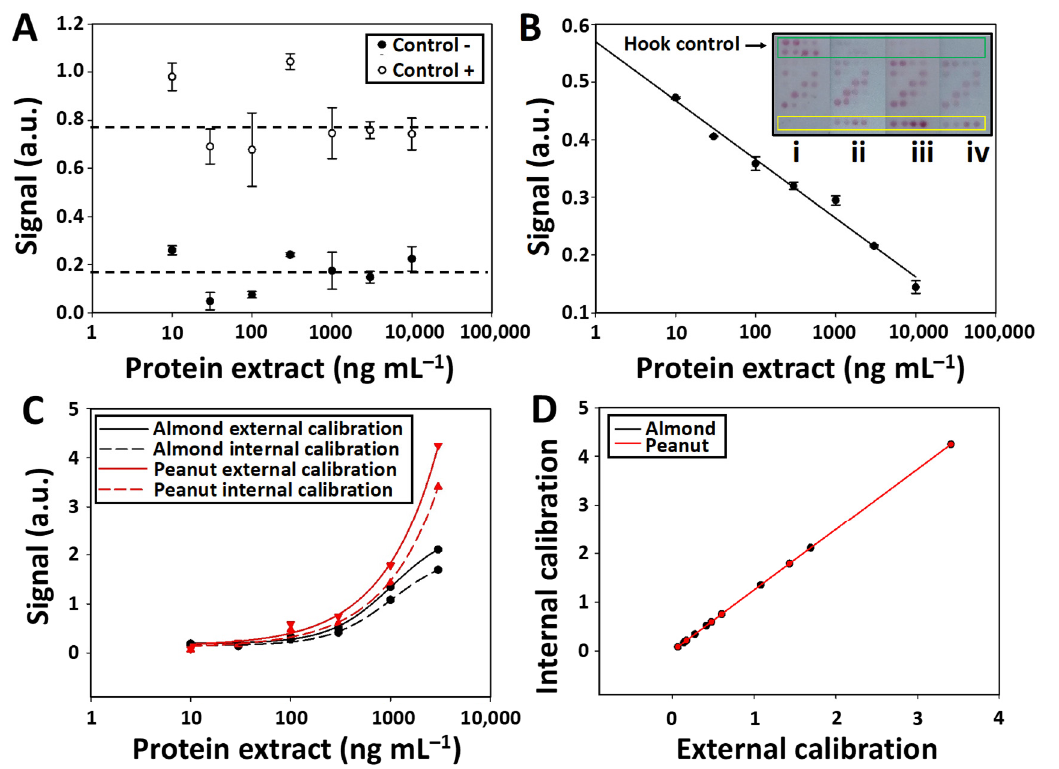
Figure 5. ( A ) Normalized (min–max) mean signal intensities in the positive (spots 3A, 4B, 5C, 6D) and negative (row R2) control assays. ( B ) Normalized mean signal intensities in the hook effect control assays (rows R8 and R9) when detecting serial dilutions of the protein extracts (10, 30, 100, 300, 1000, 3000, and 10,000 ng mL − 1 ). (B inset) Picture of the strips after the detection (i) 0, (ii) 1000, (iii) 3000, and (iv) 10,000 ng mL − 1 of the protein extracts. ( C ) Comparison of the mean signal ratio of the internal calibration curves (rows R3–R6) with the signal intensities of the external calibration curves (row R1) achieved when detecting serial dilutions of the protein extracts (10, 30, 100, 300, 1000, 3000, and 10,000 ng mL –1 ). ( D ) Mean signal intensity relationship between the internal and external calibration curves. Error bars show the standard deviation of 3 replicates.